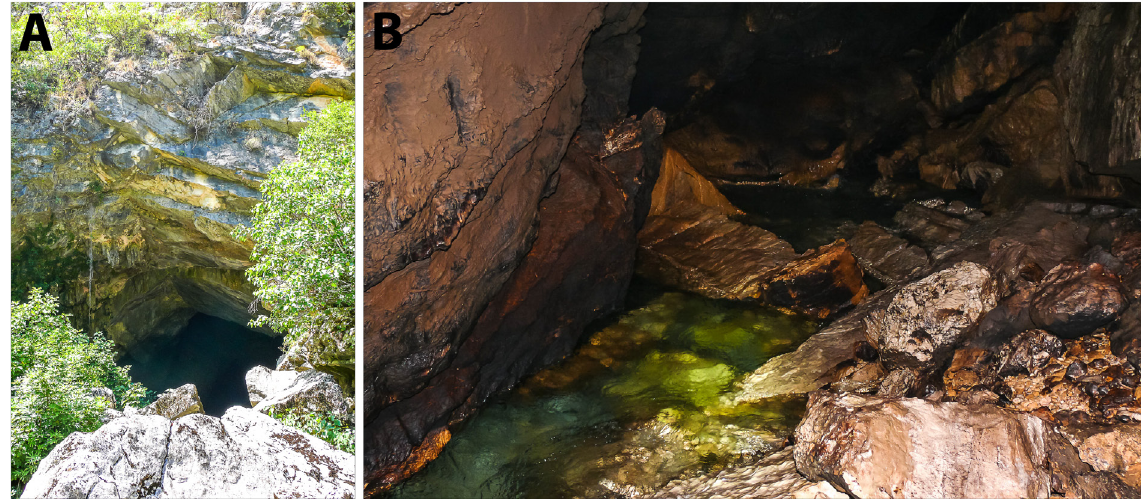
Fig. 3. Photographs of Obodska Cave. A . Entrance to the Cave. B . Sampling area inside the Cave. (Photographs by Przemysław